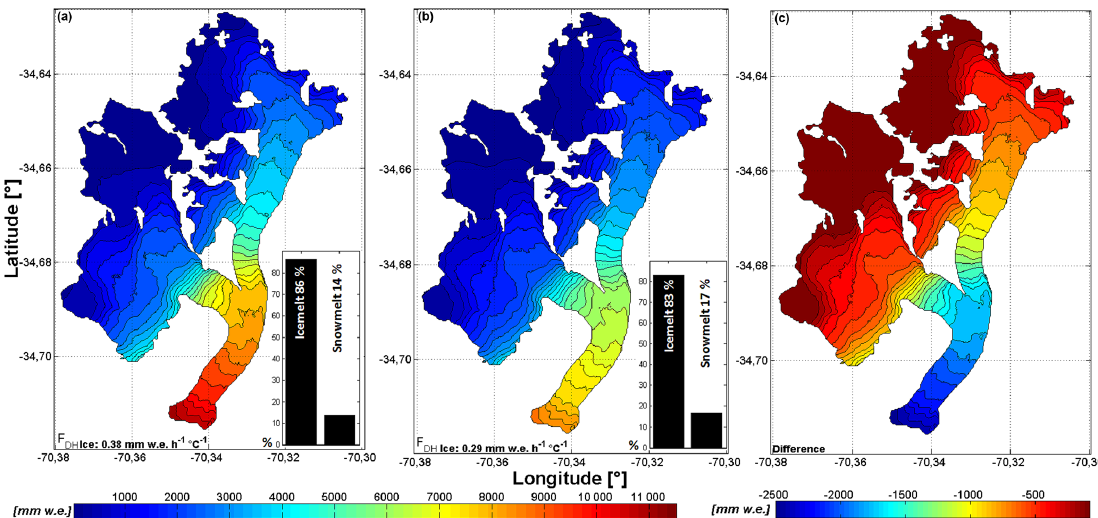
Figure 8. Spatial distribution of cumulative glacier melt from Universidad Glacier using two different F DH values for ice. (a) F DH = 0 . 38mmw.e.h − 1 ◦ C − 1 , (b) F DH = 0 . 29mmw.e.h − 1 ◦ C − 1 and (c) the difference of panels (a, b) . Totals are for the October 2009 to March 2010 period. In panels (a, b) the percentages of contributions of snow and ice surfaces to total melt are shown.